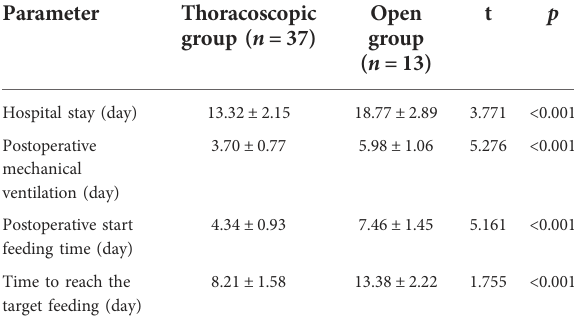
TABLE 4 Comparison of postoperative